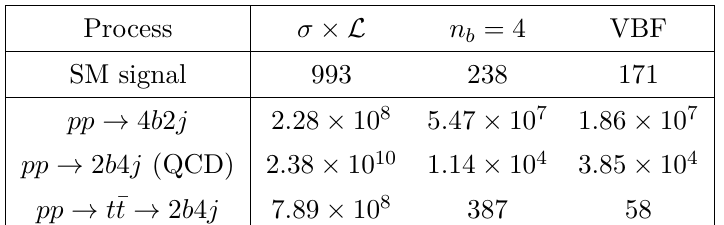
Table 2 . The cut efficiencies of b-tagging and VBF at 14 TeV LHC are demonstrated. The total integrated luminosity is assumed to be L = 3000 fb − 1 . The b-tagging efficiency is (cid:15) mis-tagging rate of light quarks is (cid:15)